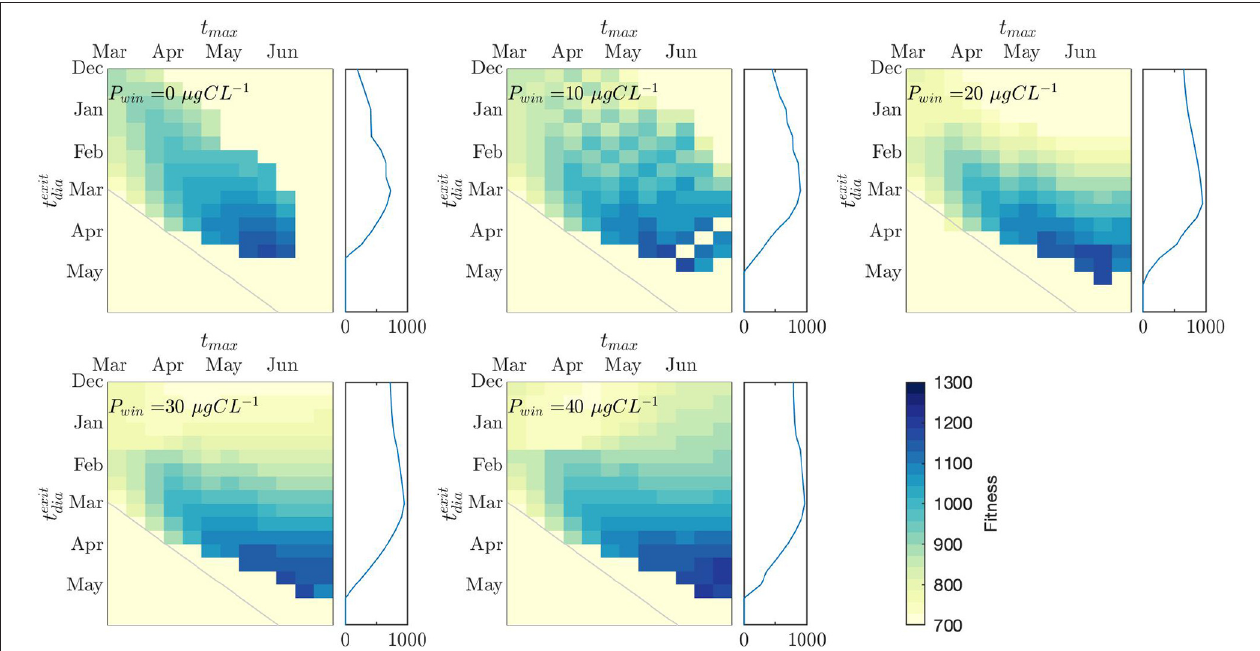
FIGURE 8 | Spring Bloom Variability Experiments. Individual plots show experiment runs for each value of P win . Fitness outcomes of each combination of diapause exit date ( t exit dia ) and the date of the spring bloom maximum ( t max ) are shown in color. The gray line indicates a 1:1 date line (i.e., exiting diapause on the same day as the spring bloom peak, t exit dia = t max . Lower left of this line is the fitness consequence of t exit dia occurring after t max , upper right is the consequence of t exit dia occurring before t max ). On the right hand side of each plot, the mean fitness consequence of each row (i.e., the mean fitness for each t exit dia across all cases of t max ) is